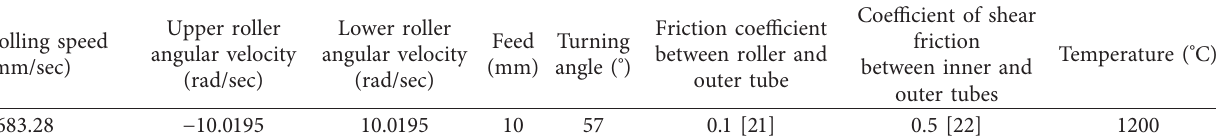
Figure 5: The finite element model of the pilger hot rolling bimetallic clad tube. Table 1: Simulation parameters of the pilger hot rolling bimetallic clad